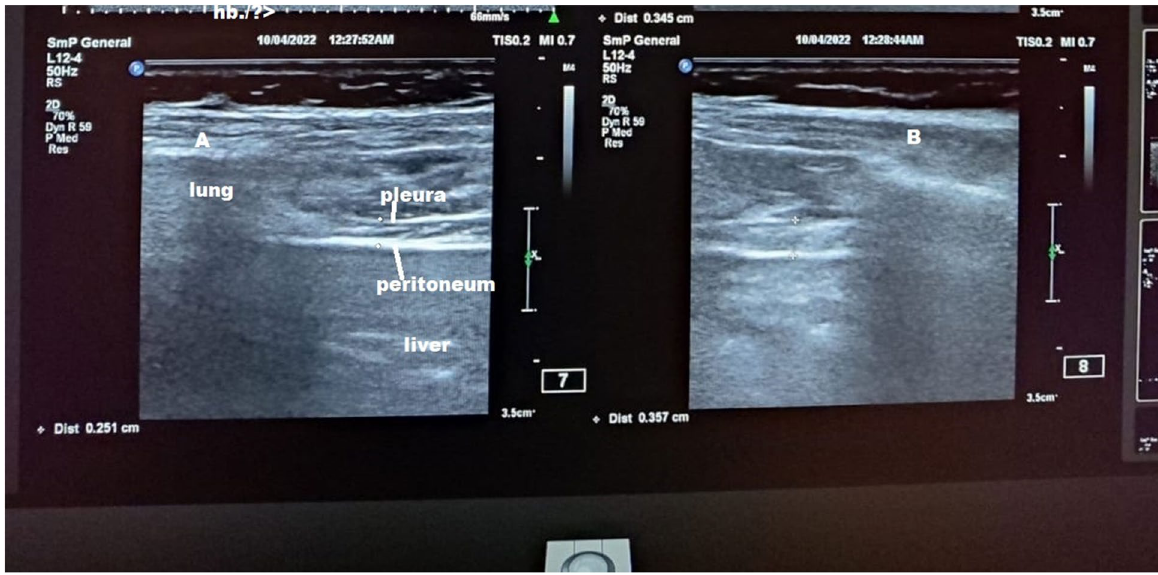
Fig. 2 Measurement of diaphragmatic thickness by the linear probe ( a ): during end expiration, ( b ) during end